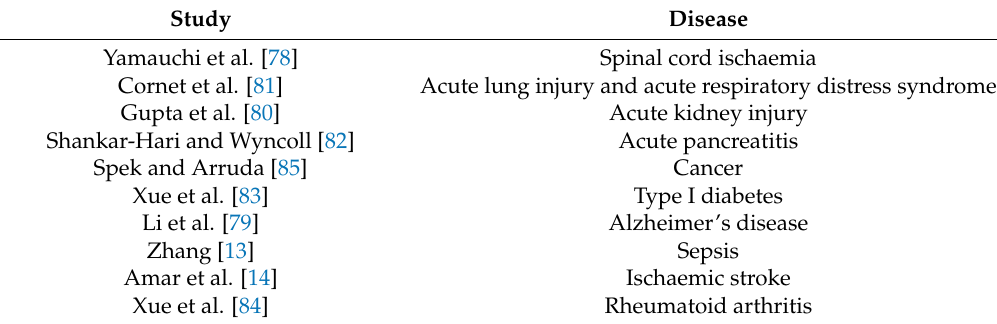
Table 3. Examples of APC’s therapeutic benefits in other